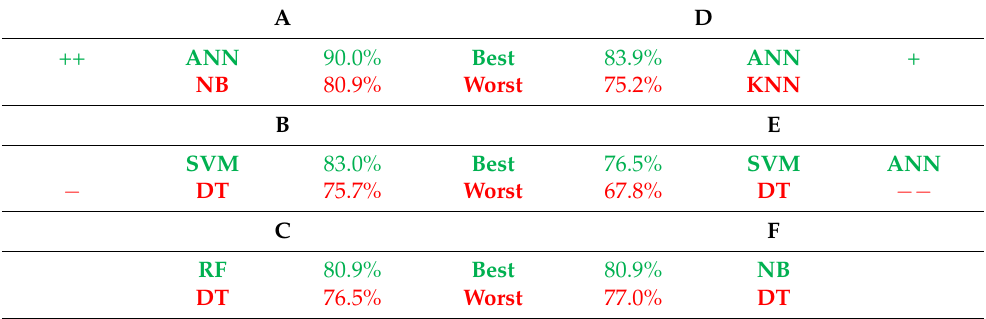
Table 3 reviews the best and worst results per variable set. Table 3. Review of best (green) and worst (red) overall-accuracy results per variable set: A, B, C, D, E, and F (six white boxes in Figure 2, Figure 5, and Figure 6). Simple machine-learning (ML) methods: naive Bayes (NB), K-nearest neighbor (KNN), and decision trees (DT). Advanced